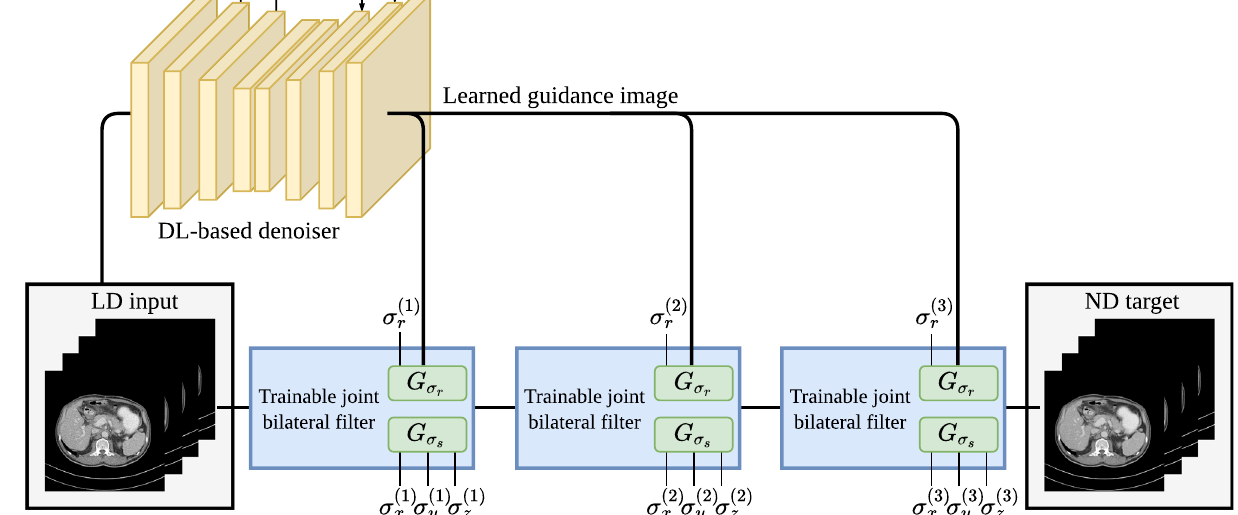
Figure 2. The investigated JBF-based denoising pipeline consists of three stacked trainable JBF layers to iteratively remove noise from the low-dose input reconstruction. Pre-trained RED-CNN and QAE models are employed as DL-based denoiser to predict guidance images. The model is trained supervised on the training domain and tested on CT data from other domains to investigate robustness properties of the pipeline. Indices (ν) with ν ∈ { 1, 2, 3 } name the individual trainable JBF layers.